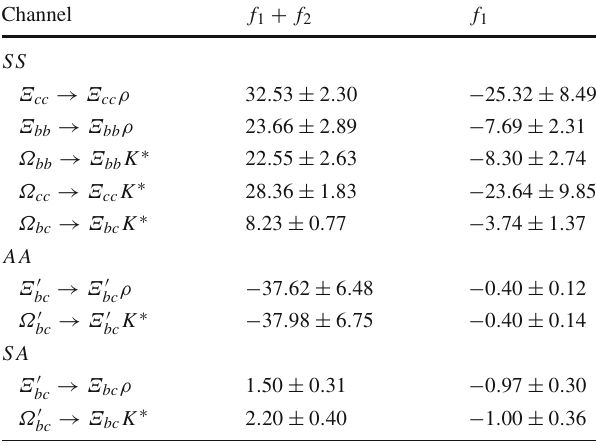
Table 3 The numerical values for the strong coupling